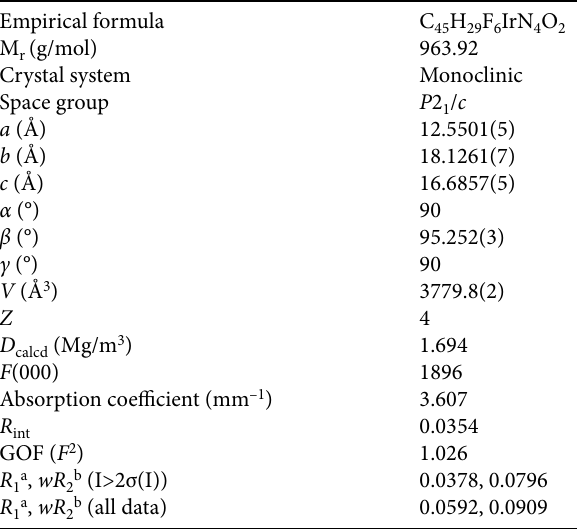
Table 1. Crystallographic data for complex 2b · H 2 O.